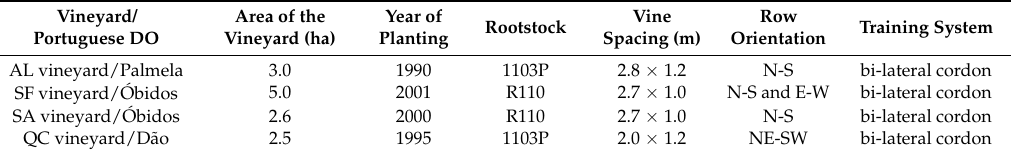
Table 1. Vineyards characteristics. (AL) Vinha de Algeruz; (SF) Quinta de S. Francisco; (SA) Quinta do Sanguinhal; (QC) Quinta dos Carvalhais. Vineyard/ Area of the Year of Vine Row Rootstock Training System Portuguese DO Vineyard (ha) Planting Spacing (m) Orientation AL